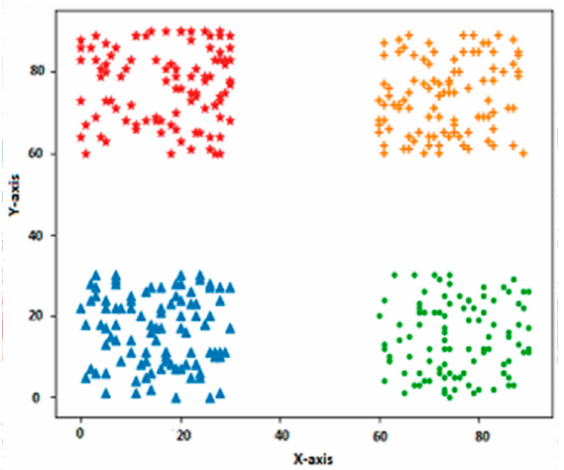
Figure 2. Four-class, linearly separable